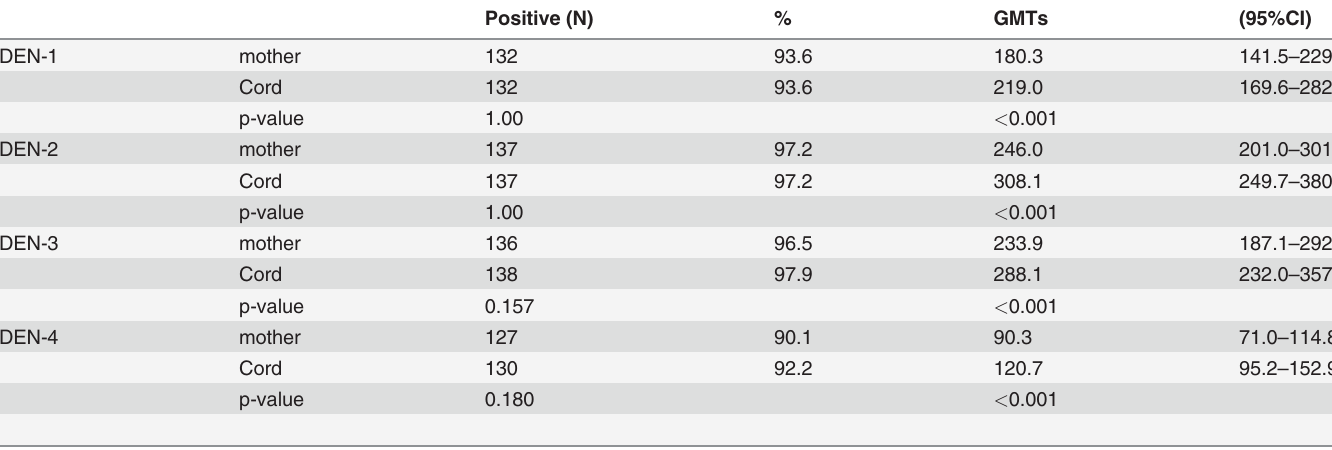
Table 2. The proportion and geometric mean titer of NT dengue antibodies of 141 maternal and cord paired